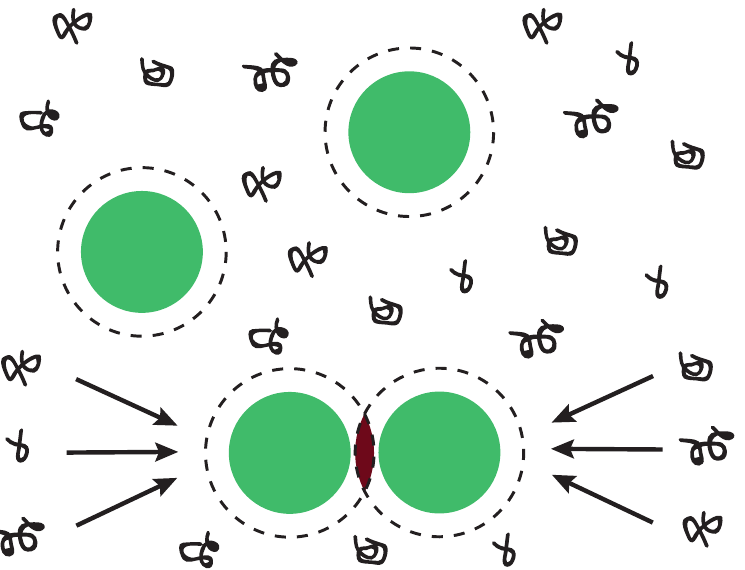
Figure 1. Schematic depiction of depletion interaction. In a mixture of colloidal spheres and non- adsorbing polymer, a depletion layer arises around the spheres as indicated by the dashed circles [16]. The centre of mass of the polymer is excluded (depleted) from this layer due to loss of configurational entropy. When two or more depletion layers overlap, the free volume available for the polymers increases. The polymers thus exert a net osmotic pressure on the colloids forcing the particles